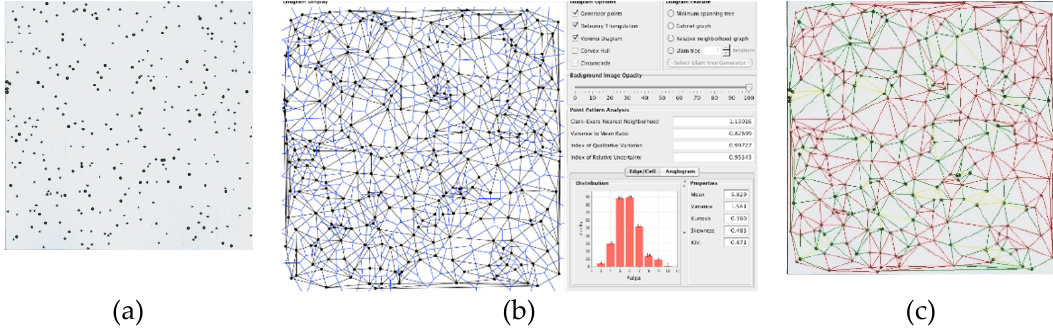
Figure 9. ( a ) Hamster tumor cells data provided by Dr. W. A. Aherne (Department of Pathology, University of Newcastle upon Tyne). The 313 nuclei of two types of cells, • are the 77 Pyknotic nuceli, and * are the 236 metaphase nuclei. ( b ) Using the Ka-me_0_84 program, the points to create both a Voronoi diagram and Delaunay triangulation. ( c ) Edges shared by metaphase-Pyknotic, and dotted lines show the edges Pyknotic-Pyknotic cells share.